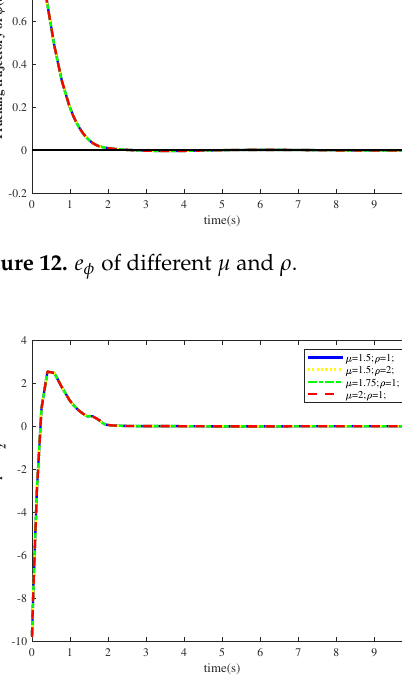
Figure 13. U 2 of different µ and ρ .